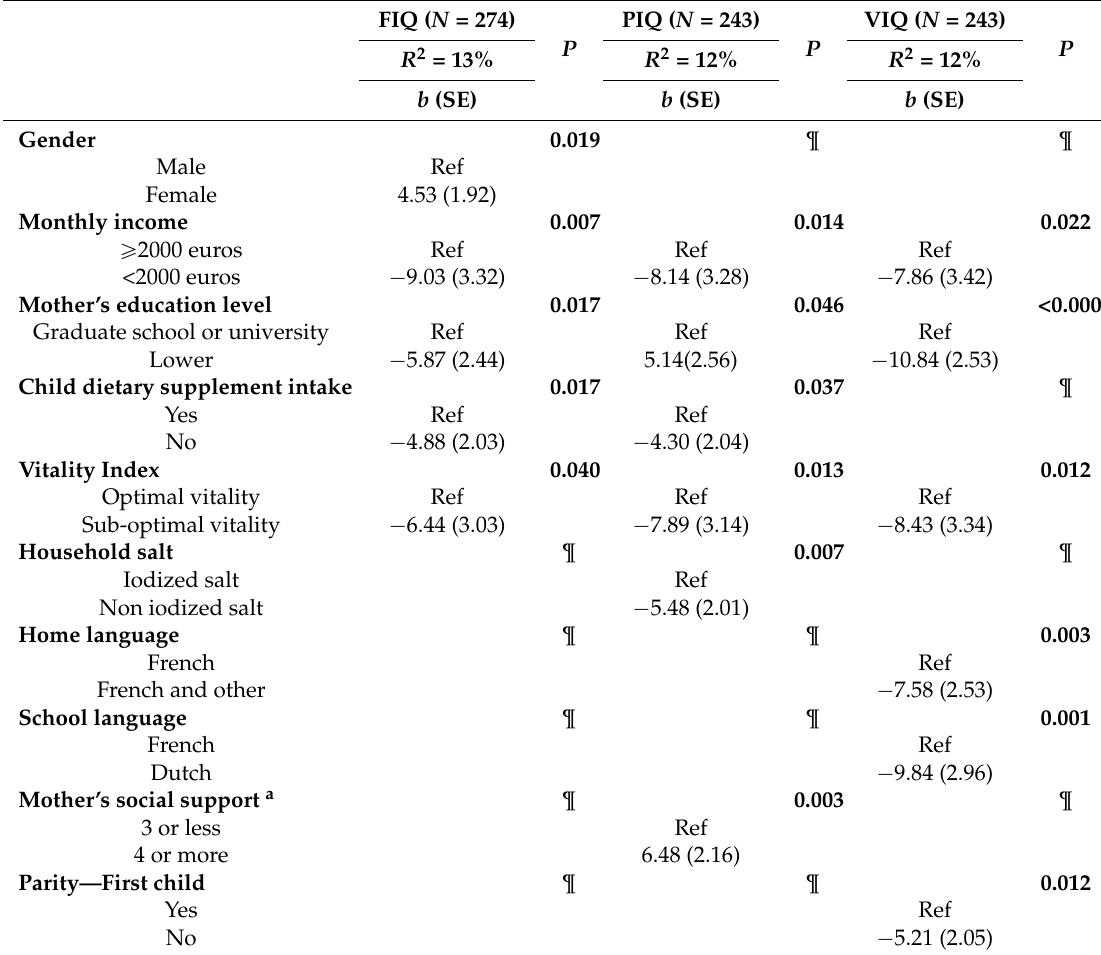
Table 5. Multiple linear regression of factors explaining variation cognitive scores at preschool